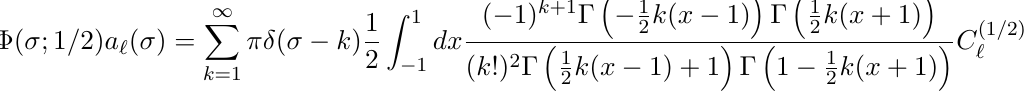
absorptive part is given by A ( s work in four space-time dimensions, i.e., α = 1 / 2 . The partial wave coefficients are given